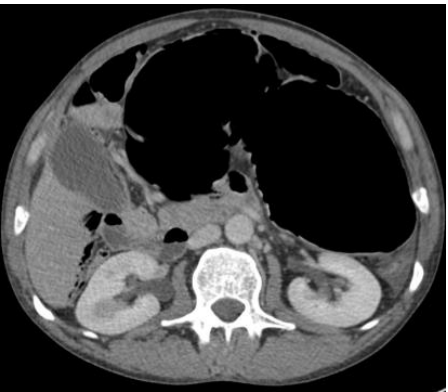
Figure 4. CT axial image demonstrating a grossly distended caecum with diameter > 10 cm.